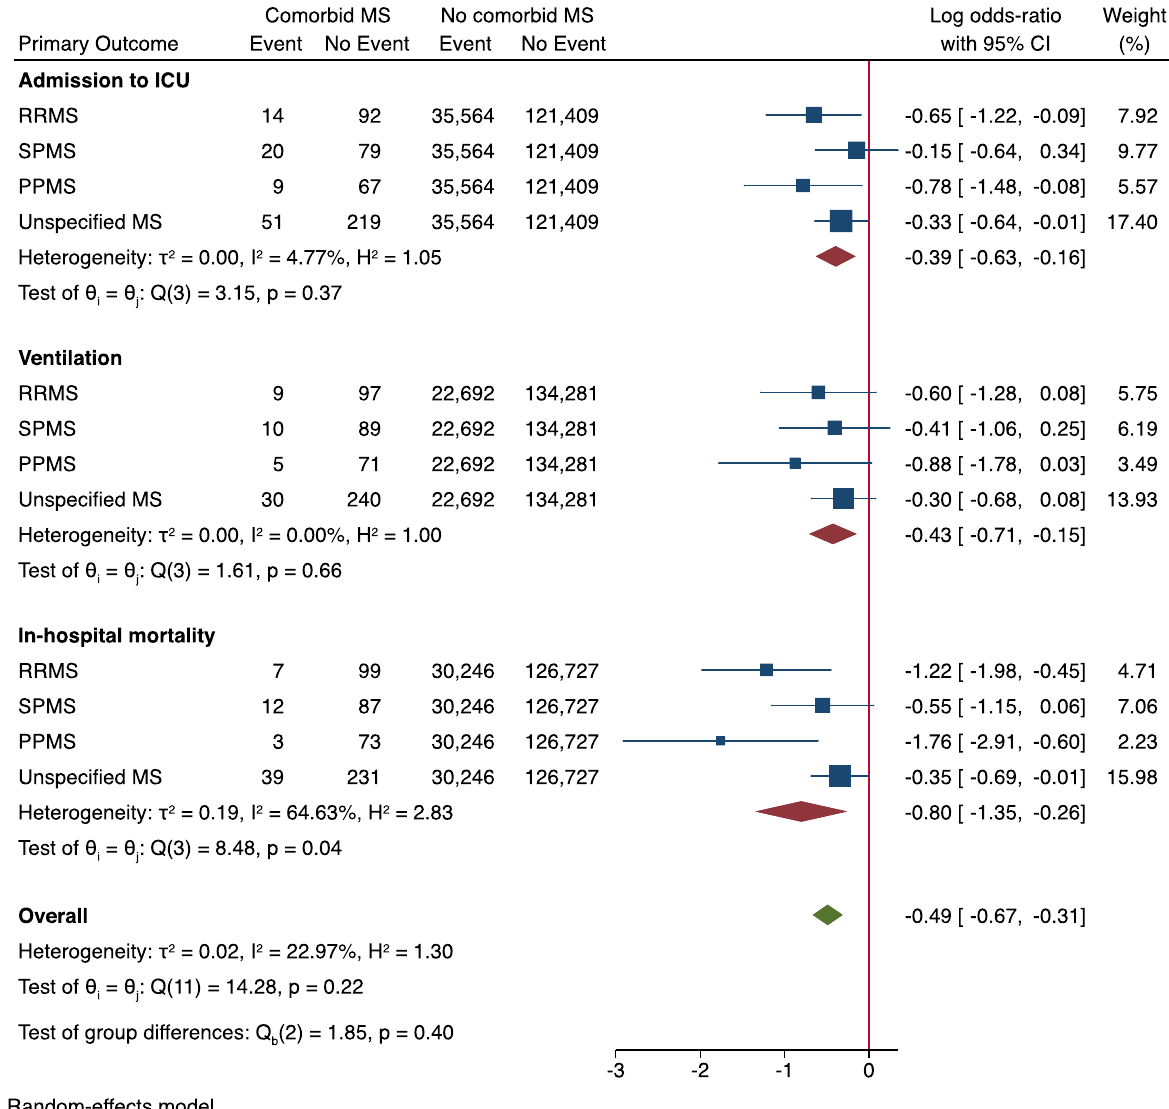
Fig. 2 Primary outcome parameters stratified by MS-subtype. Log odds-ratio < 0 indicates a lower risk for patients with comorbid MS. Abbreviations: ICU = intensive care